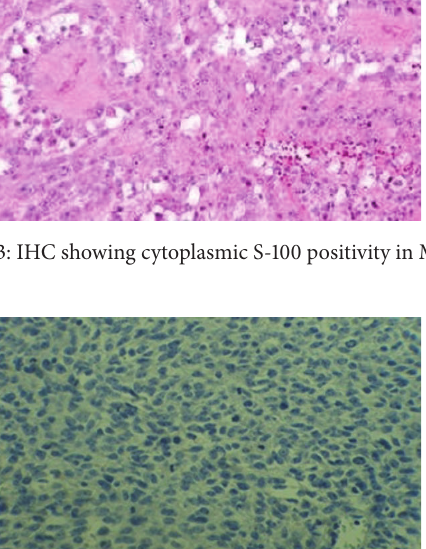
Figure 2: Nuclear hyperchromasia, enlargement, and crowding in MPNST ( × 400).